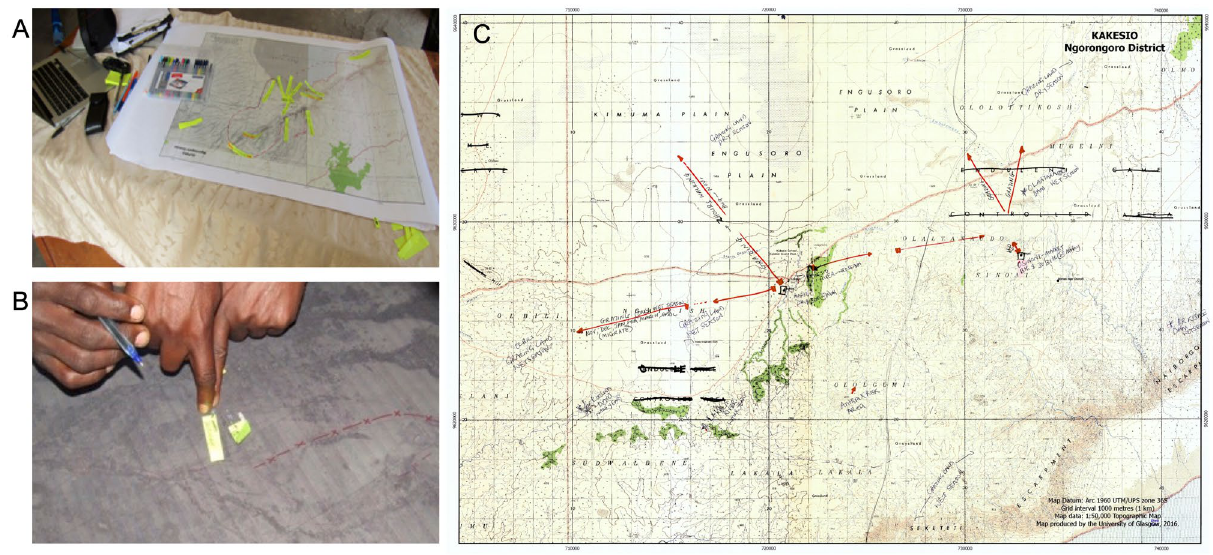
Figure 2. Participatory mapping of anthrax risk areas in the Ngorongoro Conservation Area. Images show ( A ) the set-up of a mapping session, ( B ) participants engaged during a session and ( C ) an example of a 1:50,000 scale map annotated by participants. The map was created with QGIS opensource mapping software. The basemap used was a scanned and geo-referenced full colour 1:50,000 scale topographic map produced by the Surveys & Mapping Division, Ministry of Lands, Housing & Human Settlements, Dar es Salaam, Tanzania. The grid is based on the Arc1960 UTM 36S projection and datum. The map was exported from QGIS in Acrobat Pdf format to enable it to be printed at suitable sizes for using in the fieldwork and to be manually annotated during the participatory mapping.